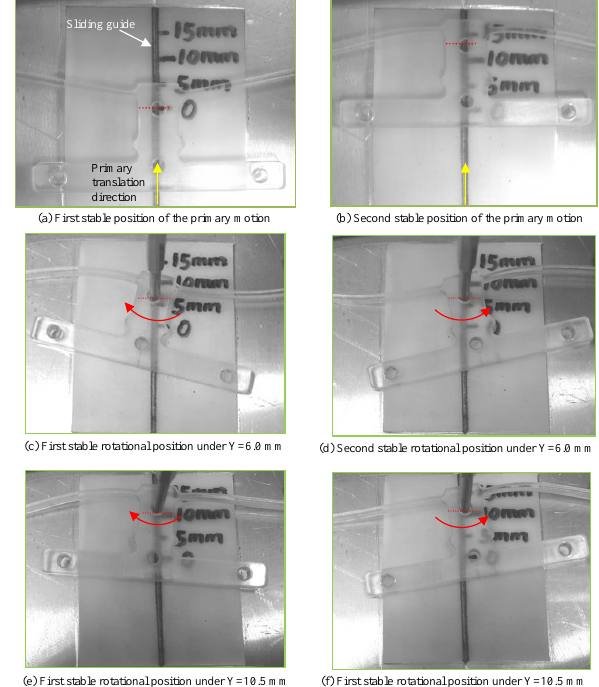
Figure 8. Fabricated